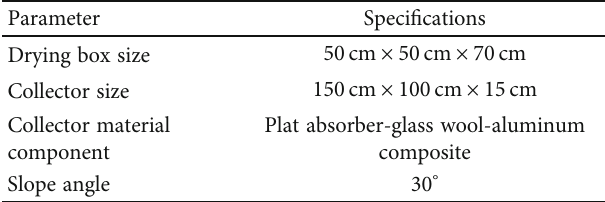
Figure 1: The solar dryer details from solar energy systems. Table 1: Speci fi cation of the solar